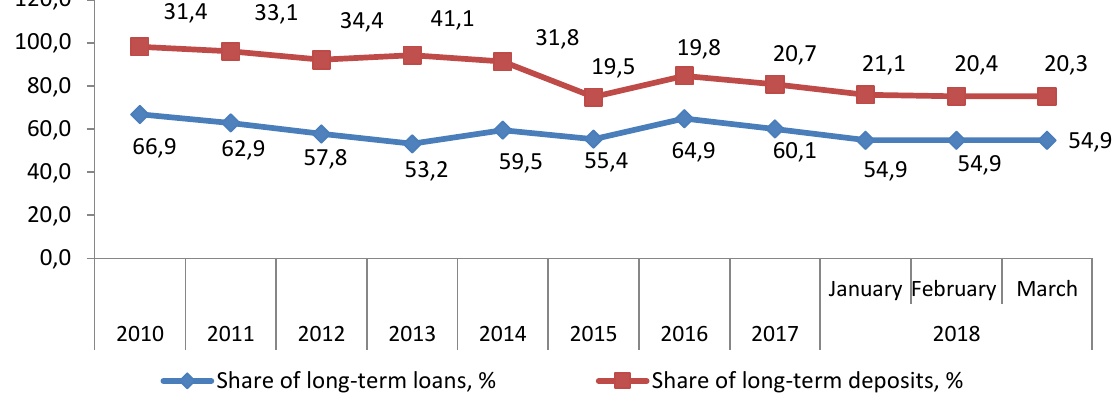
Figure 1. Share of long-term loans and deposits in the Ukrainian banking